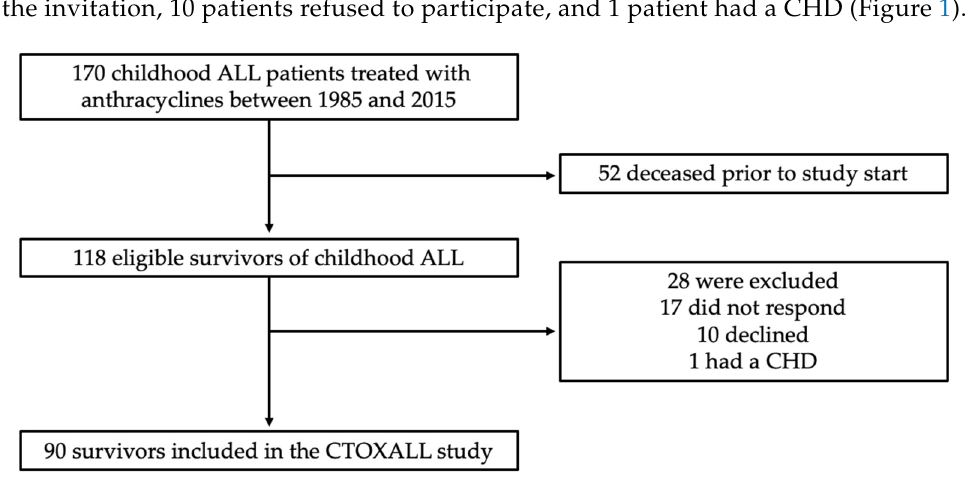
Figure 1. Flow diagram of the childhood leukemia survivors included in the analysis. ALL, acute lymphoblastic leukemia; CHD, congenital heart defect.